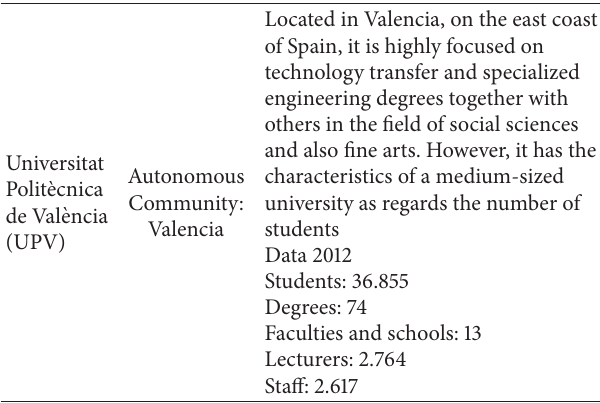
Table 1: General characteristics of the